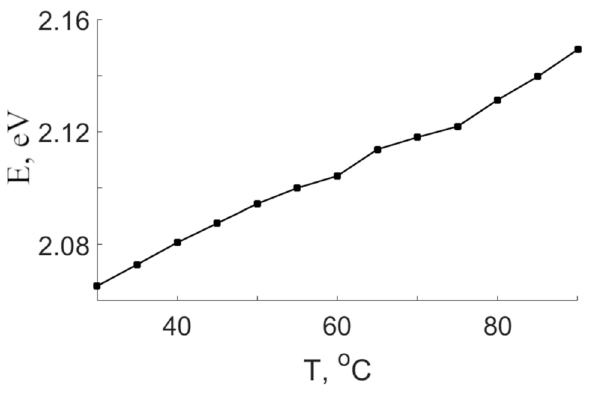
Figure 10. Dependence of the 2.04 eV maximum position on the CLN crystal temperature.